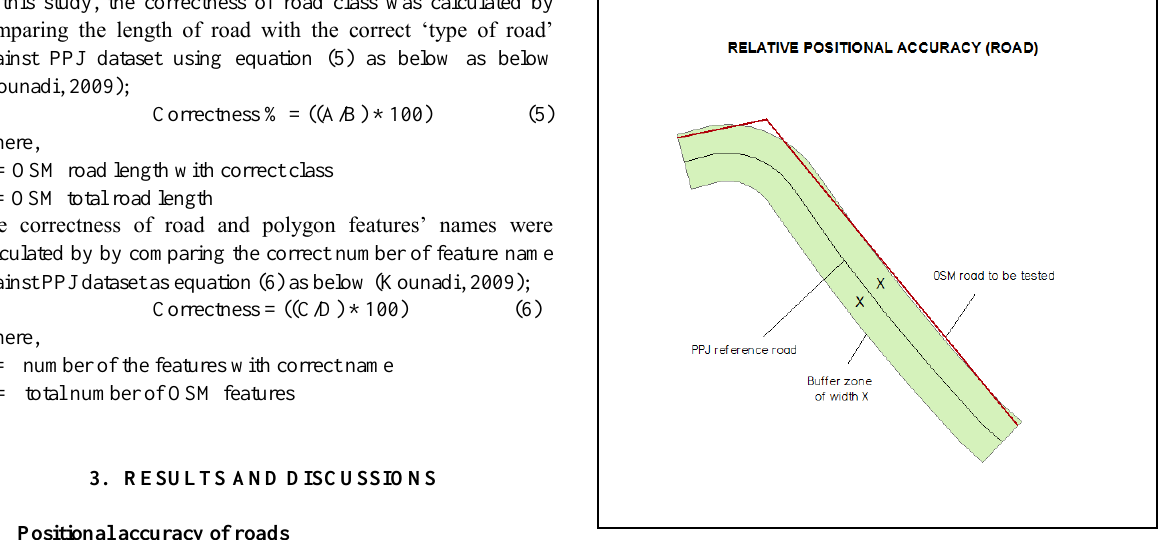
Figure 3: A snapshot of overlap between two roads